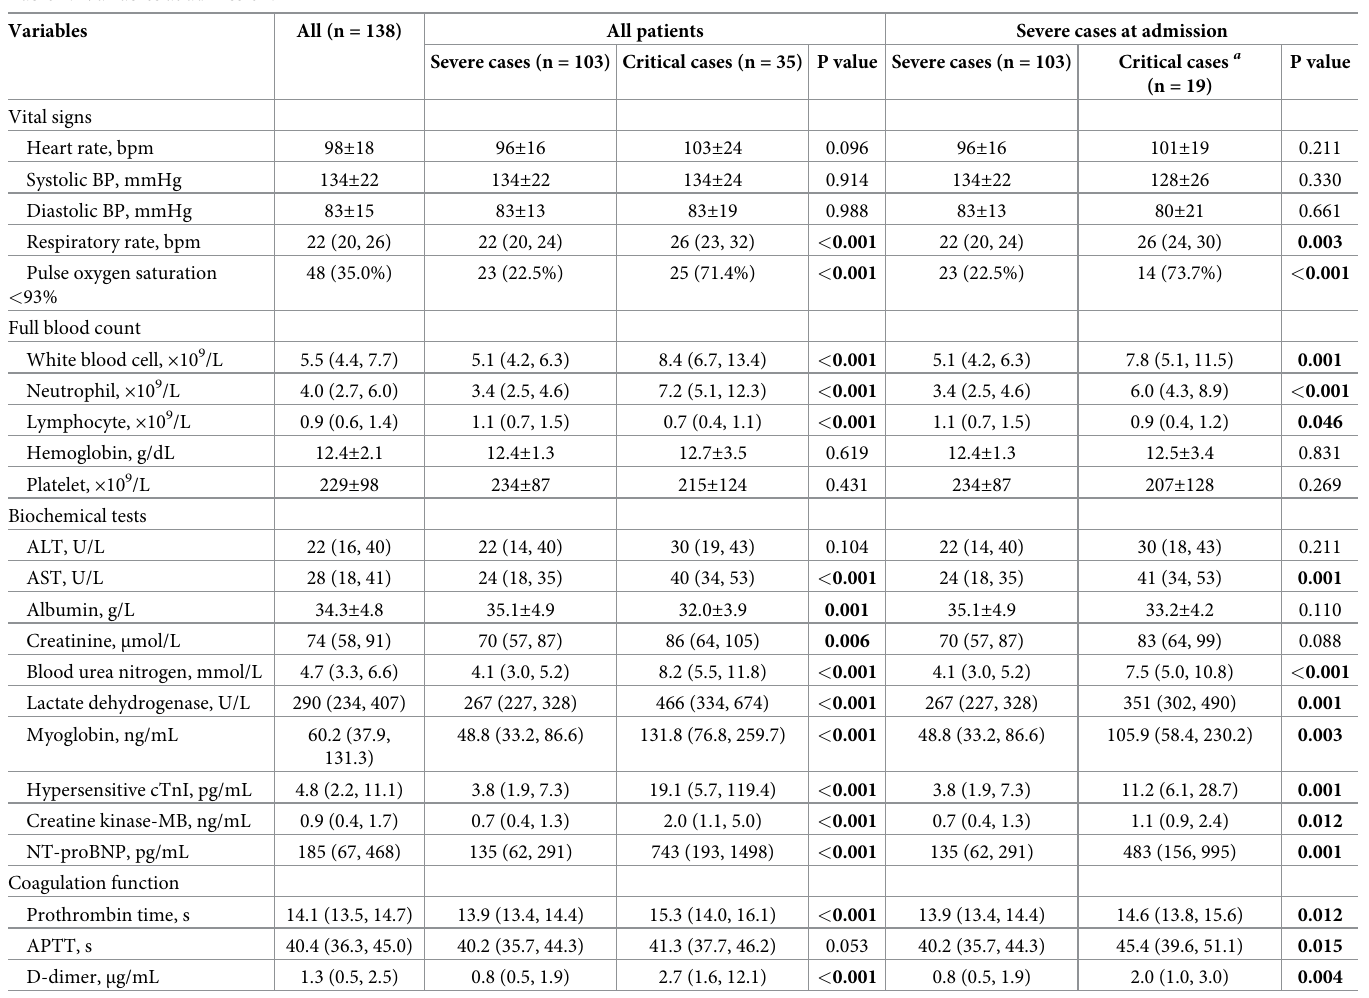
Table 2. Variables at